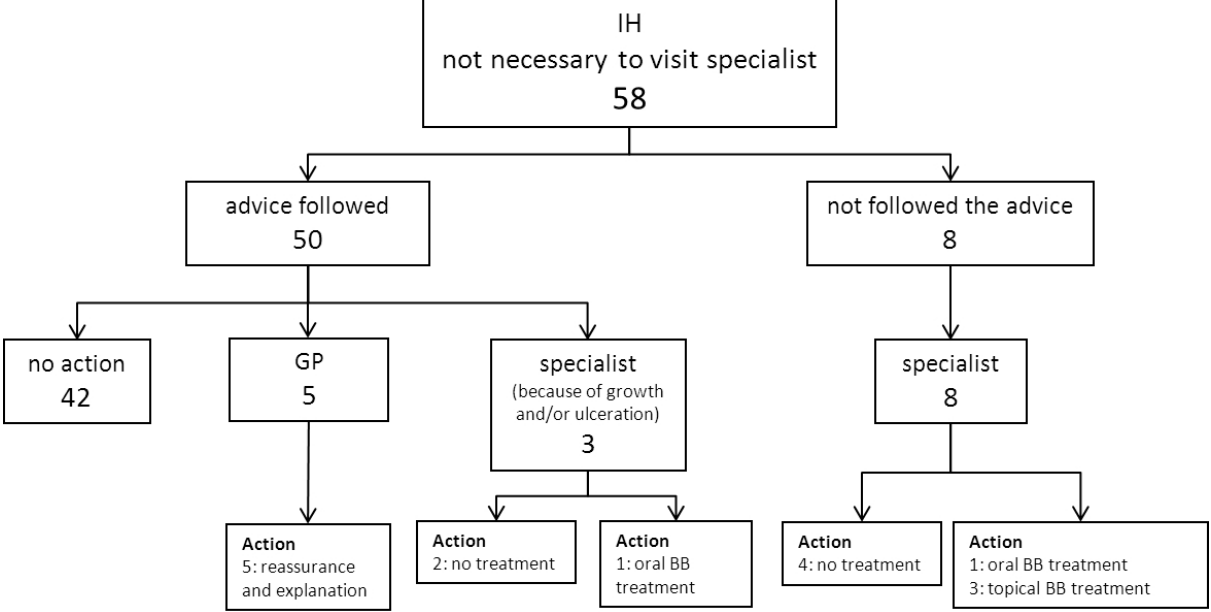
Figure 2. Flowchart of the compliance of the parents who were advised not to visit a medical specialist by the dermatologist via e-consultation. The flowchart shows which doctor the parents visited and to what actions (eg, diagnostic evaluation and/or treatment) it has led. The figures indicate the number of patients. Infantile hemangioma(s) (IH); general practitioner (GP); and beta blocker (BB).